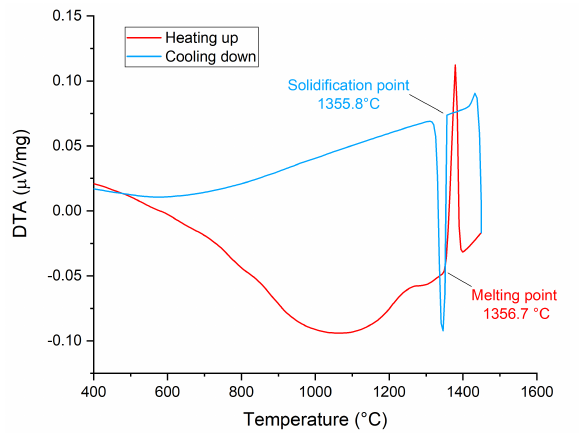
Figure 4. The determined melting point and the solidification point of Cr-Ni